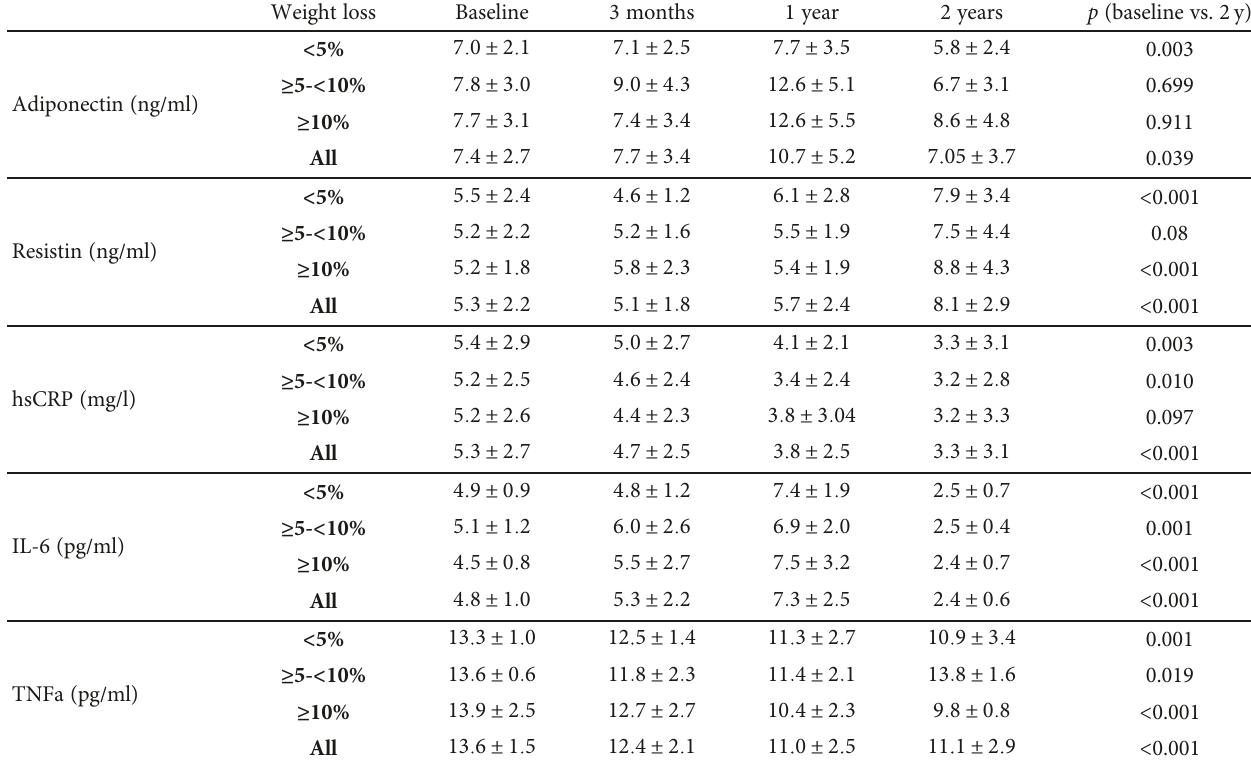
Table 4: Adipokine and in fl ammatory biomarker levels at baseline vs. after 2 years of lifestyle modi fi cation, according to percentage of weight loss. MHO participants: baseline, n = 115 ; 3 months, n = 104 ; 1 st year, n = 75 ; and 2 nd year, n = 67